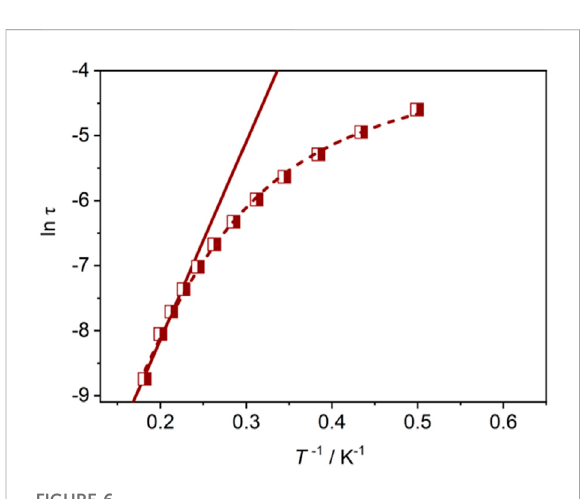
FIGURE 6 ln τ vs. T − 1 plot for Dy-CP and the Arrhenius law τ − 1 = τ 0 − 1 exp (- U eff /k B T) (solid) and Equation τ − 1 = AH 2 T + CT n + τ 0 − 1 exp (- U eff / T ) (dashed) fi tting k B